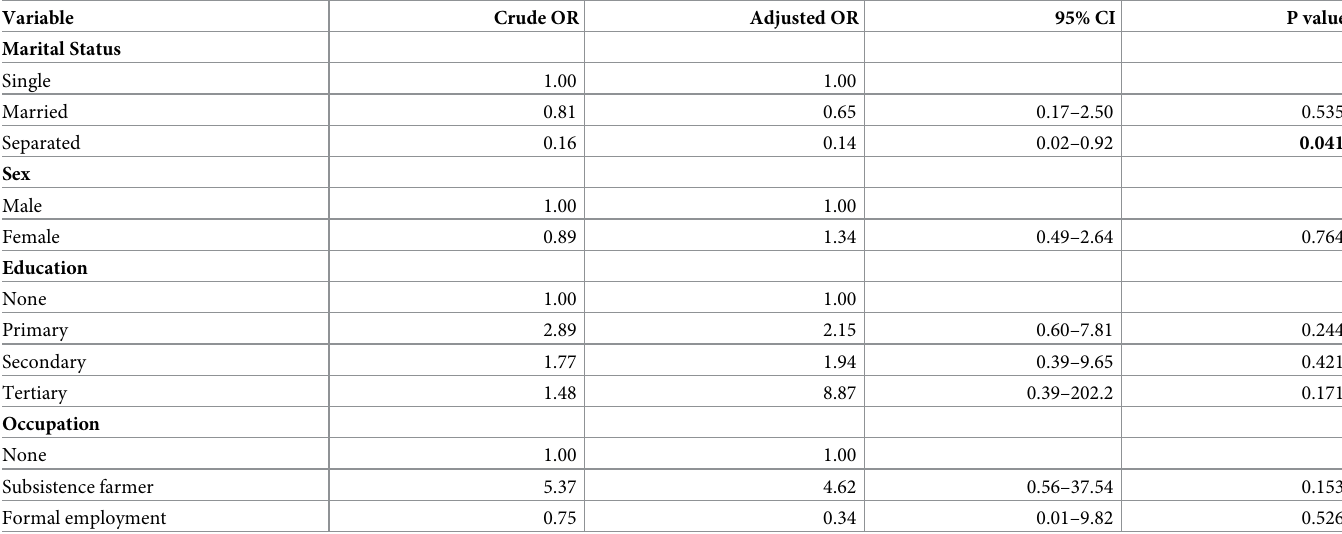
Table 3. Factors associated with uptake of community ART